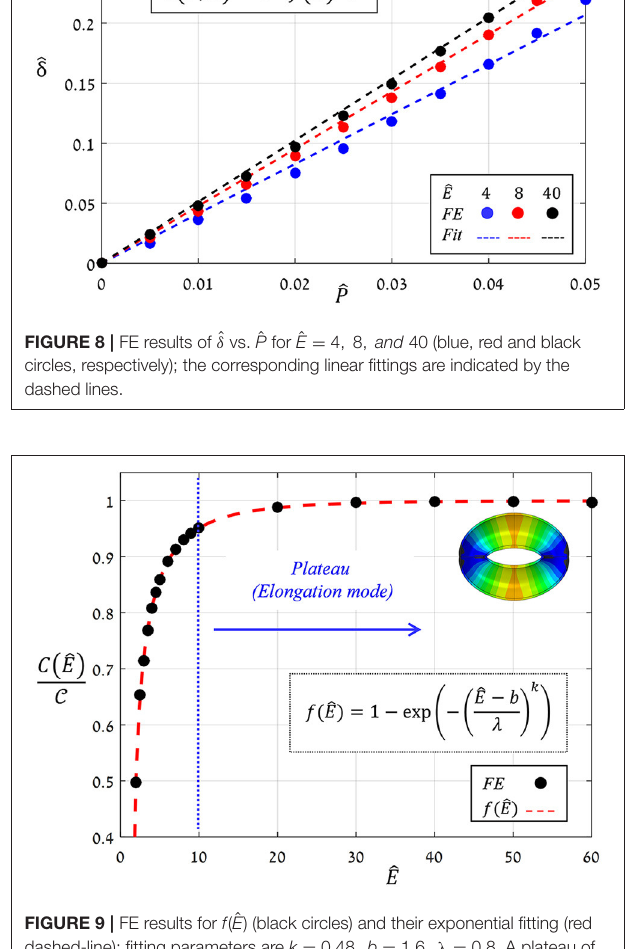
0.48, b 1.6, λ 0.8. A plateau of = = = * 10, above which guard cell =